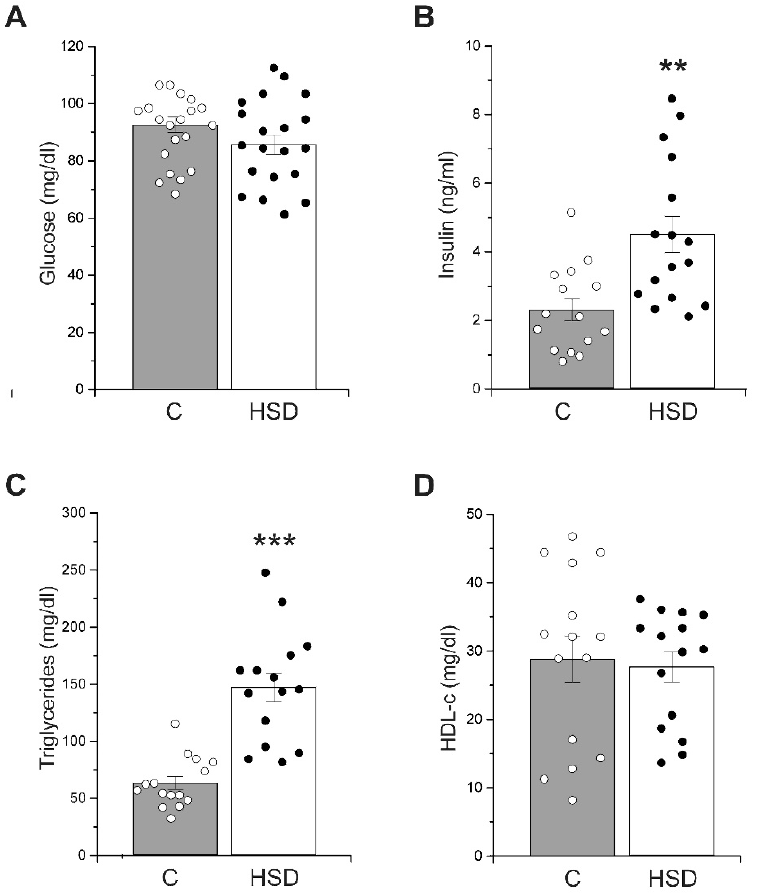
Figure 2. Metabolic status. ( A ) Fasting glucose levels of HSD group compared to the control group. Boxes around the mean represent SE and whiskers represent the SD, n = 20 of each condition. ( B ) Plasma insulin levels from control ( n = 15) and HSD ( n = 15) groups. Boxes around the mean represent SE and whiskers represent the SD. One-way ANOVA was performed with post hoc Tukey’s test, ** p < 0.0001 compared to the control group. ( C ) Plasma triacylglycerols levels from control ( n = 15) and HSD group ( n = 15). Boxes around the mean represent the SE, and whiskers represent the SD. One-way ANOVA was performed with post hoc Tukey’s test, *** p < 0.01 compared to the control group. ( D ) High-density lipoprotein cholesterol (HDL-c) from control group ( n = 15) and HSD group ( n = 15). Boxes around the mean represent SE and whiskers represent the